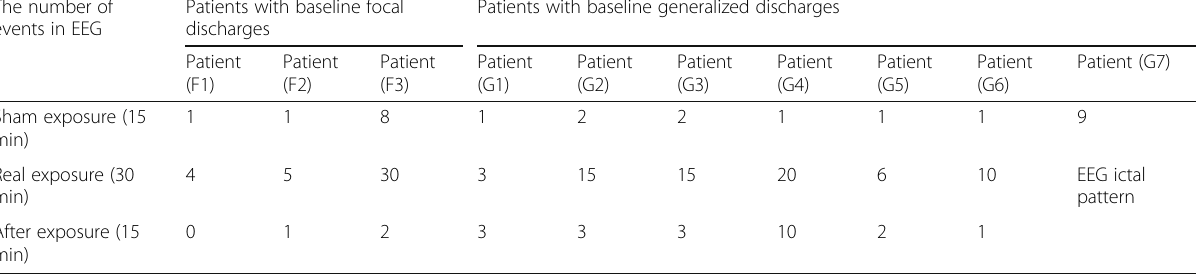
EEG electroencephalogram, F focal, G generalized, min